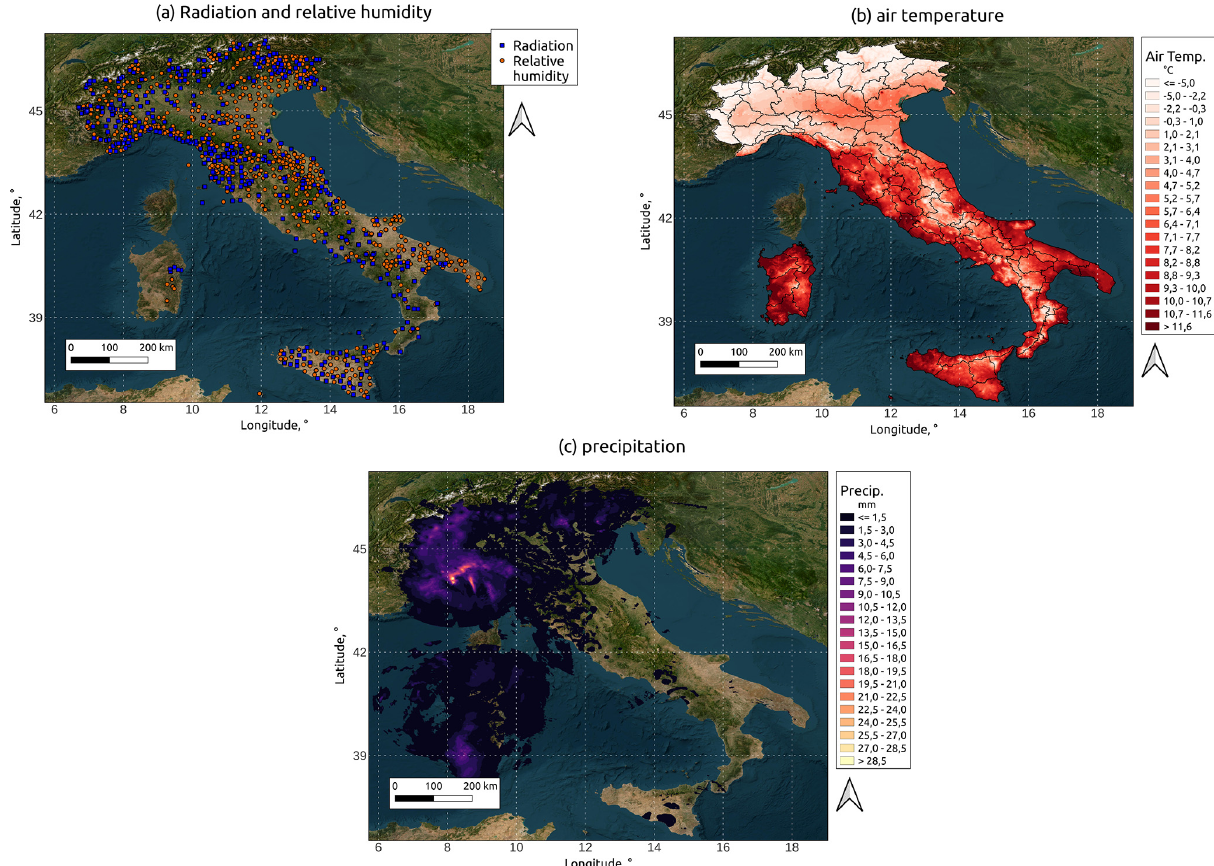
Figure 2. Examples of input data used by S3M Italy to produce the IT-SNOW reanalysis. (a) Location of the radiation and relative humidity sensor stations for 4 February 2021 at 10:00UTC. (b) Air temperature map for 14 February 2022 at 20:00UTC, along with delineation of meteorological homogeneous regions in black (2019 update). (c) Precipitation map based on a modified conditional merging between precipitation gauges and radars for 23 November 2019 at 09:00UTC (Bruno et al., 2021). Background map from the Esri satellite theme. Note that some stations in panel (a) may host both types of